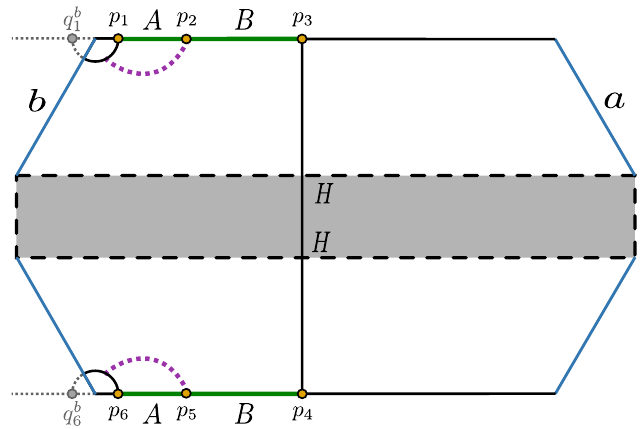
Figure 9 . Here q b = r I − (cid:15) and q b = r I − (cid:15) are the mirror images of the points p 1 = r I + (cid:15) and p 6 = 1 6 r I + (cid:15) respectively with respect to the b -boundary. Also the other points in the two BCFT 2 s are identified as p 2 = r , p 3 = r 1 , p 5 = r and p 4 = r 1